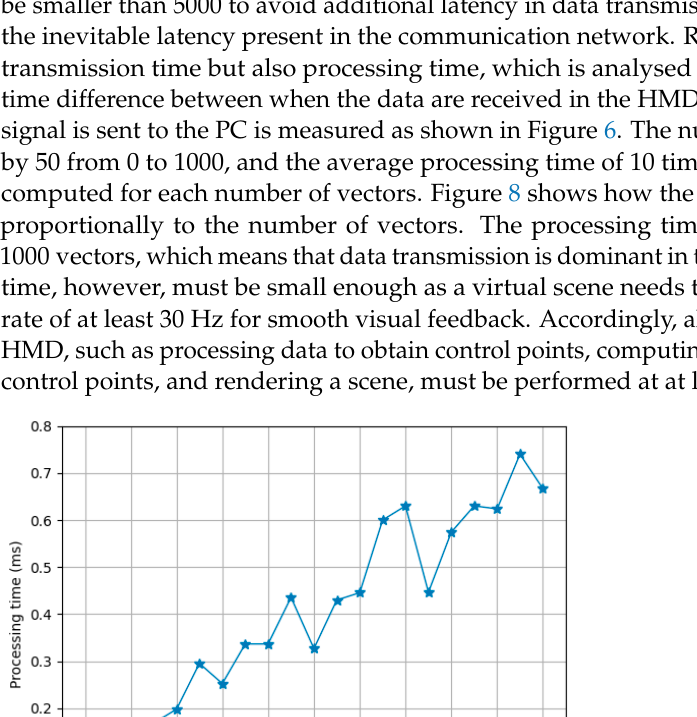
Figure 7. Round-trip time (RTT) against the number of vectors.